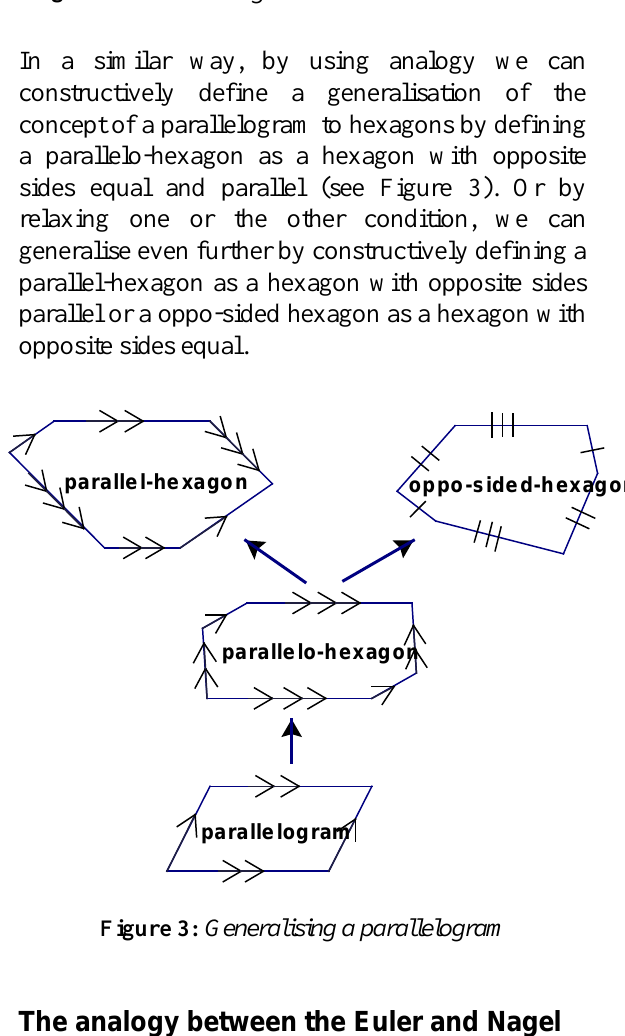
The analogy between the Euler and Nagel lines of a triangle Analogy seems to have a share in all discoveries, but in some it has the lion’s